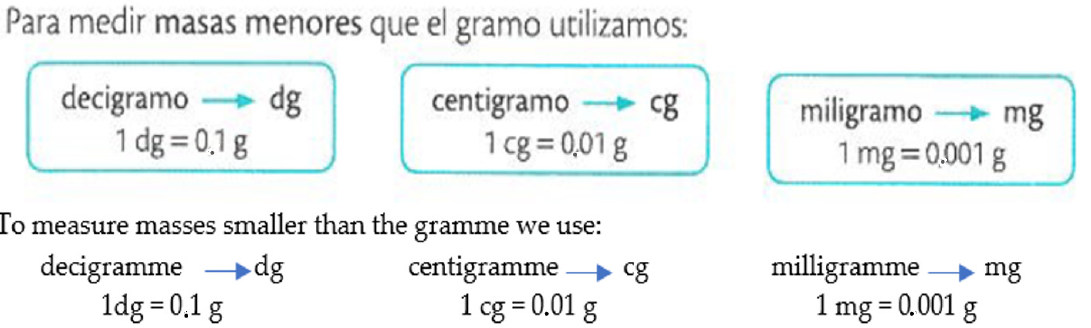
Figure 3. Measurement skills for ( left ) mass and ( right ) volume.